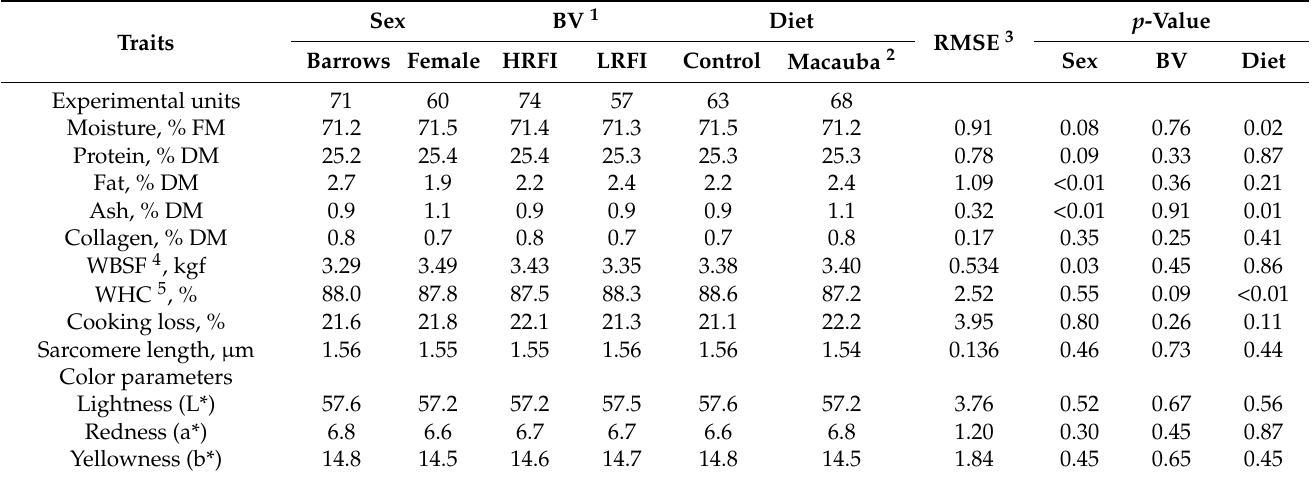
Table 5. Effect of sex, sire breeding value, and diet on pork quality parameters of growing- finishing